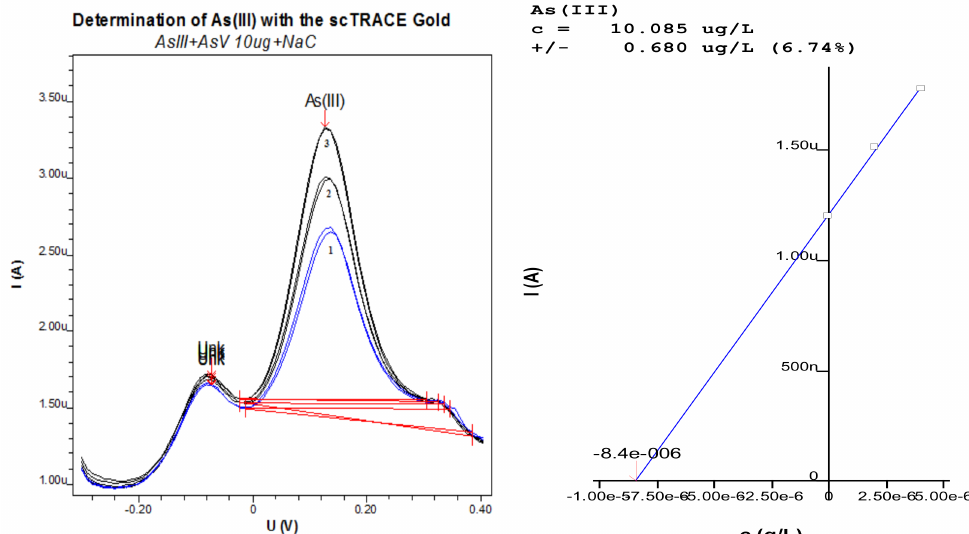
Figure 1. Resulting voltammogram obtained for the determination of As(III) in As(III)/As(V) 10 µ g L − 1 model sample with the addition of NaC solution in a final concentration c = 2 × 10 − 3 mol L − 1 (1); (2) after the first addition 30 µ L of 1 × 10 − 3 mol L − 1 As(III) standard solution; (3) after the second addition of the same standard solution and corresponding analytical curve. Voltammograms obtained for As(tot) determination in As(III)/As(V) 10 µ g L − 1 model sample with OX solution as a preservative (c(OX) = 2 × 10 − 3 mol L − 1 ) and corresponding analytical curve are shown in Figure 2. Measurements were performed one hour after the preparation of the